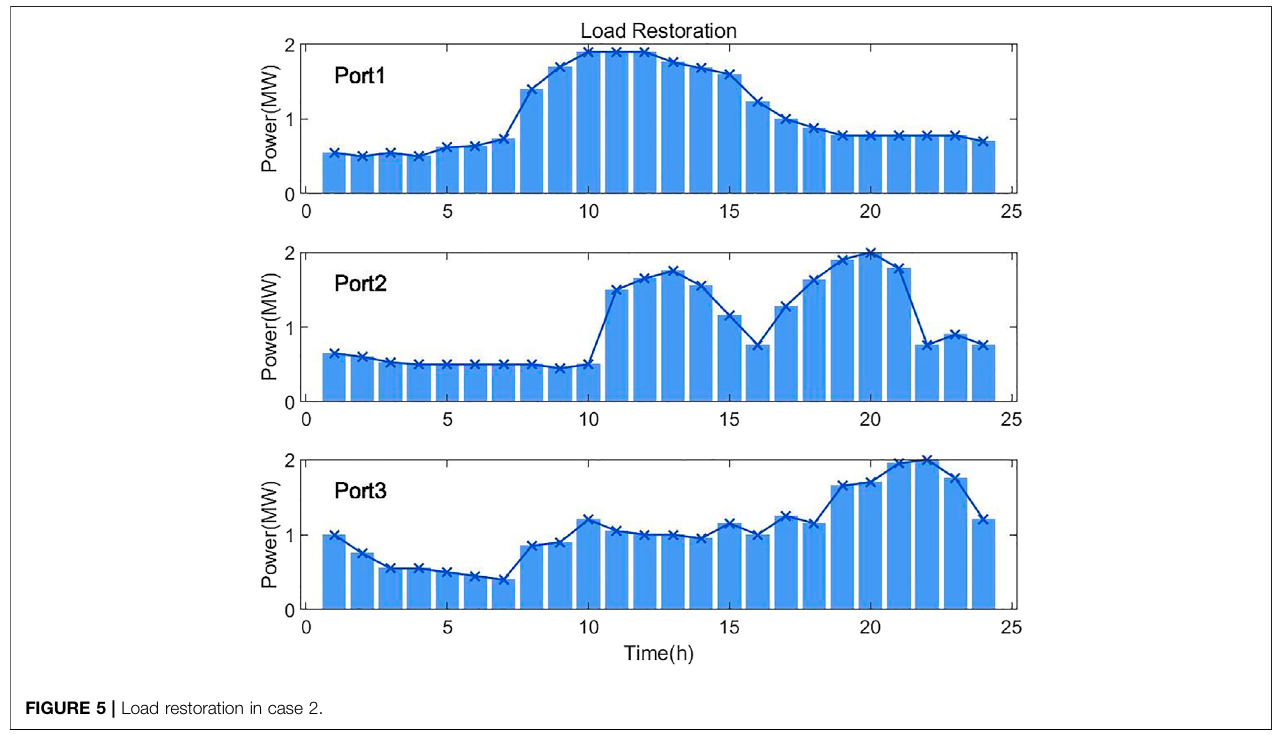
FIGURE 5 | Load restoration in case 2.